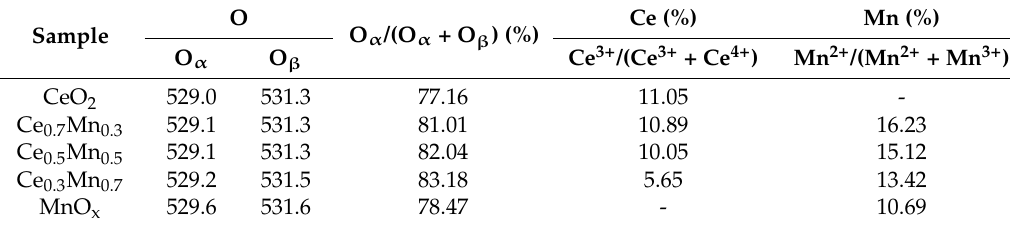
Figure 4. X-ray photoelectron spectra in the Ce 3d ( a ), Mn 2p ( b ), Mn 3s ( c ), O 1s ( d ) regions for the Ce x Mn 1 − x catalysts. Table 2. XPS results of Ce x Mn 1 − x samples.